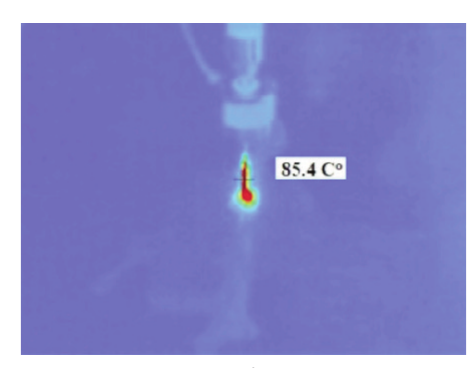
Thermal camera image of the drill bit reaching 85.4°C at Fig. 5: the third hole (Drill 1).